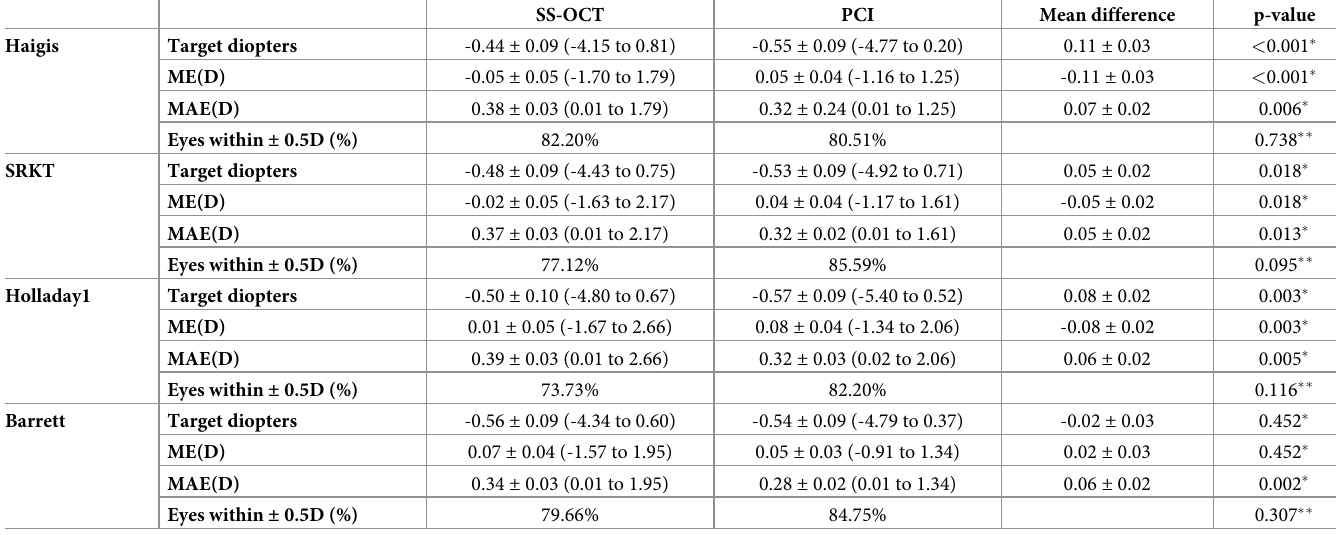
Table 3. Mean arithmetic error and mean absolute error of IOL power calculation using data from two biometrics.